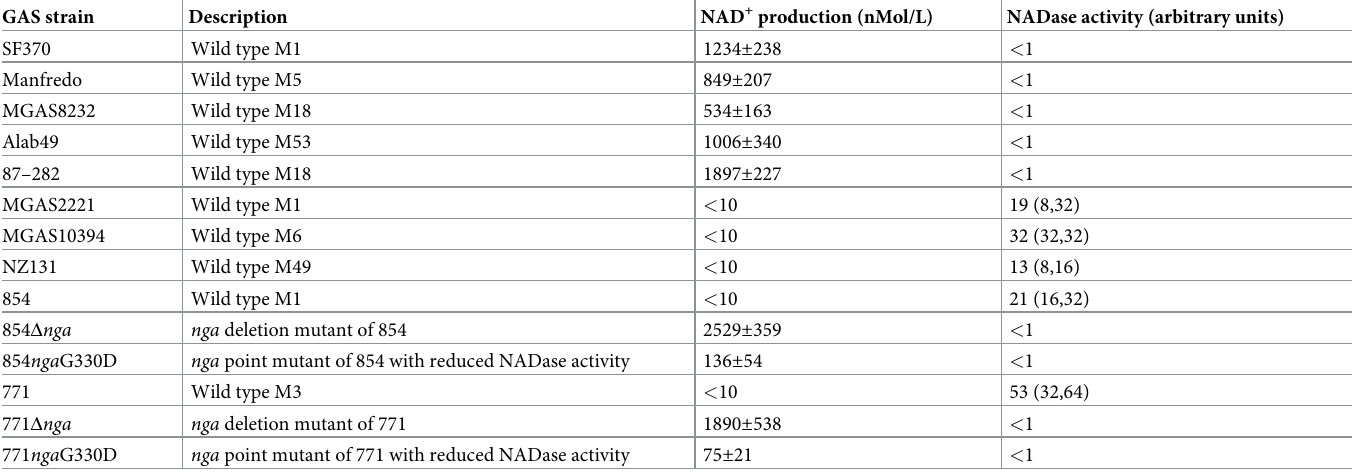
Table 1. NAD production and NADase activity of GAS strains. For NAD + production, values represent mean ± SD or the lower limit of detection for assays of three independent biological samples; for NADase activity, values represent mean endpoint titer (range) or the lower limit of detection for assays of three independent biological